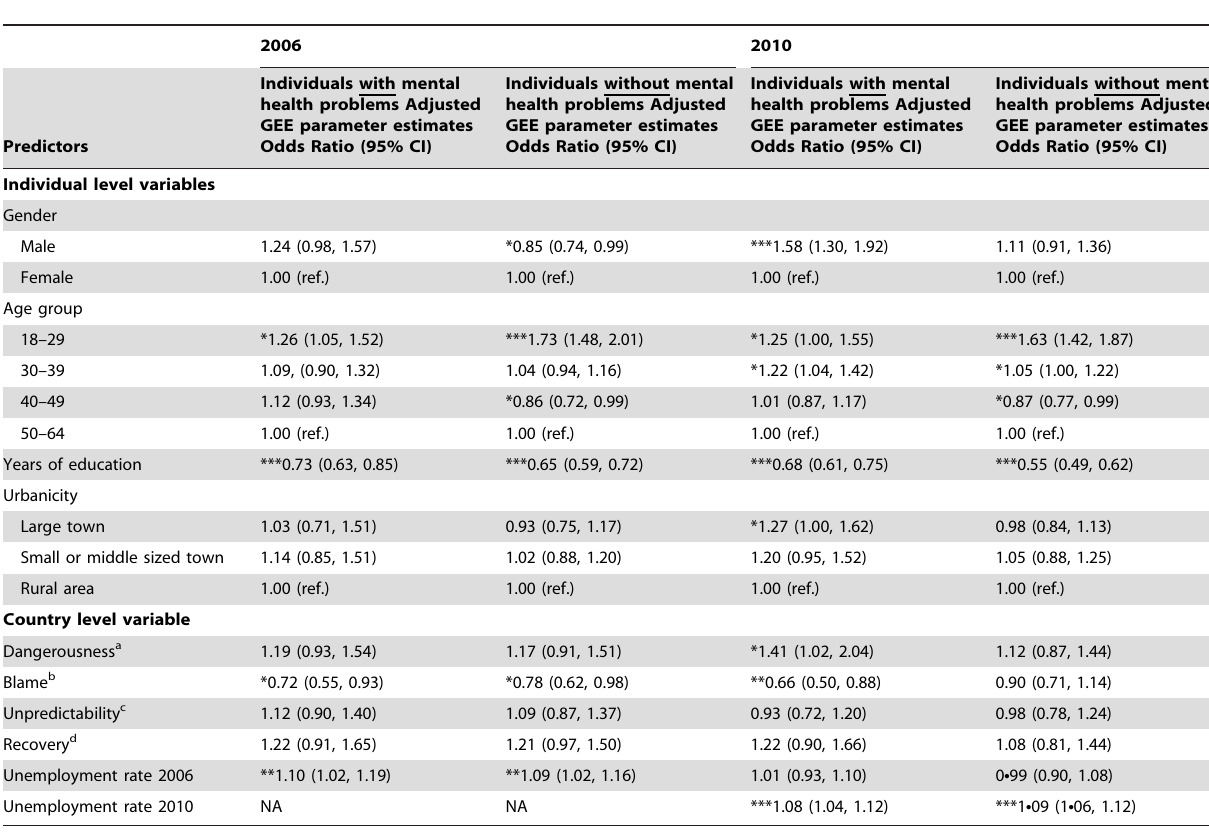
Table 2. Results of multivariable logistic regression analyses for predictors of unemployment stratified by presence of mental health problems in Eurobarometer 2006 and